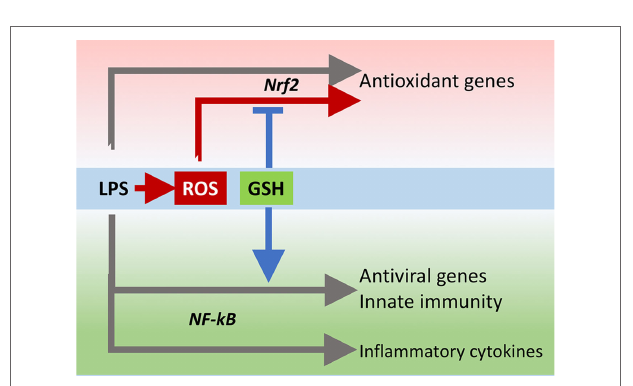
FigUre 10 | GSH fine-tuning of TLR4 signaling. LPS triggers TLR4 to induce gene expression of inflammatory cytokines, antioxidant genes, and antiviral/ immunity pathways. GSH orients the TLR4-mediated changes in gene expression profile toward activation of host defense. GSH, glutathione; LPS, lipopolysaccharide; TLR4, toll-like receptor